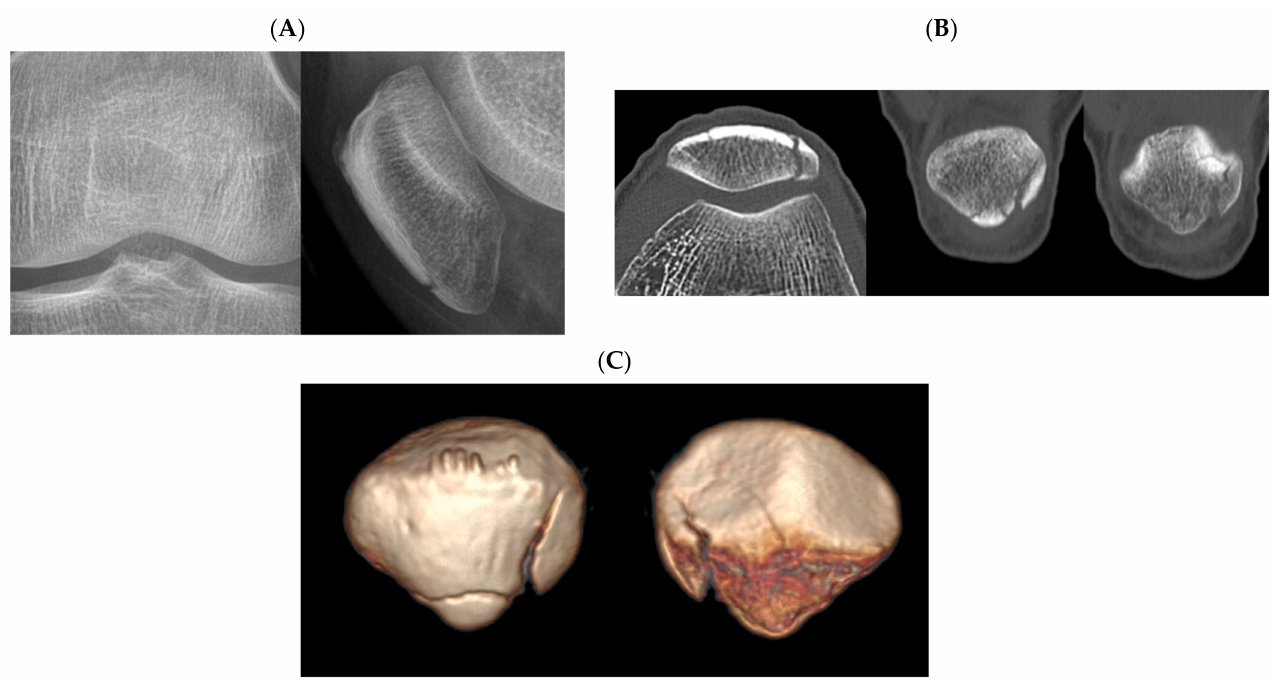
Figure 4. Plain radiographs ( A ), two-dimensional computed tomography ( B ), and three-dimensional computed tomography ( C ) of a patellar fracture with fracture lines of both horizontal and vertical fracture lines. The respondents chose either type A or